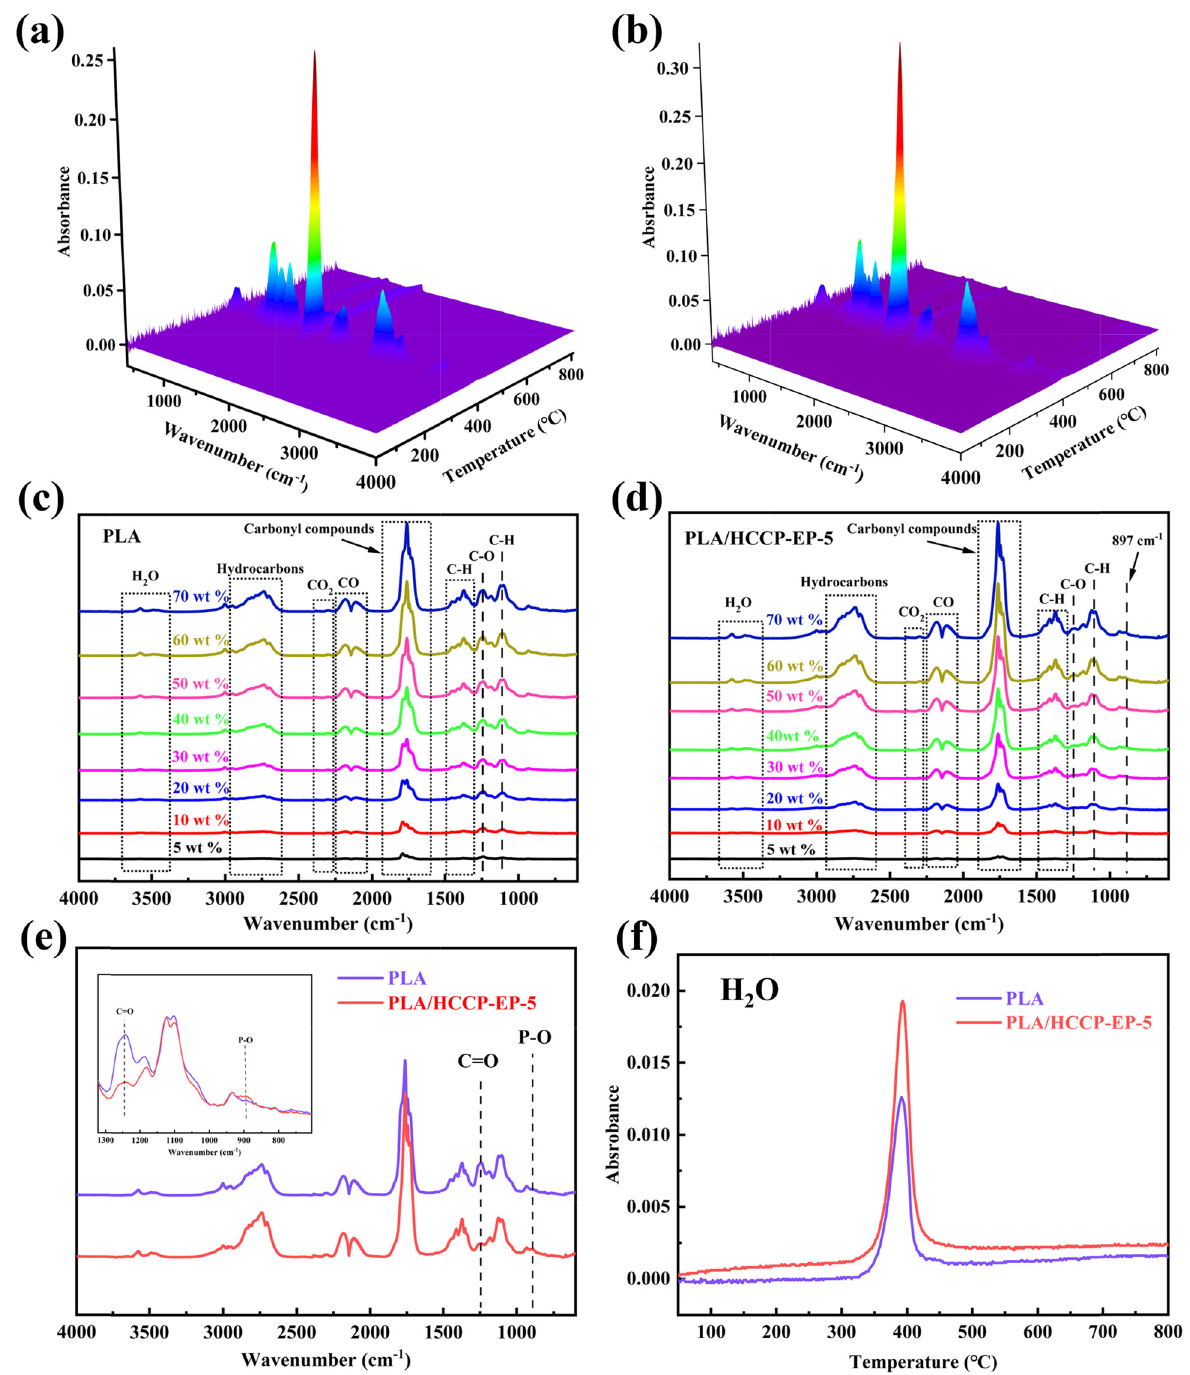
Figure 7: The3Dimageof ( a ) TG - IRresultsforPLAand ( b ) PLA/HCCP - EP - 5.FT - IRspectraofthegaseous productsatdi ff erentmasslossfor ( c ) PLAand ( d ) PLA/HCCP - EP - 5. ( e ) TheFTIRspectraofgaseousproductsat amaximumdecompositionrate. ( f ) Time - dependentFTIRspectraofH